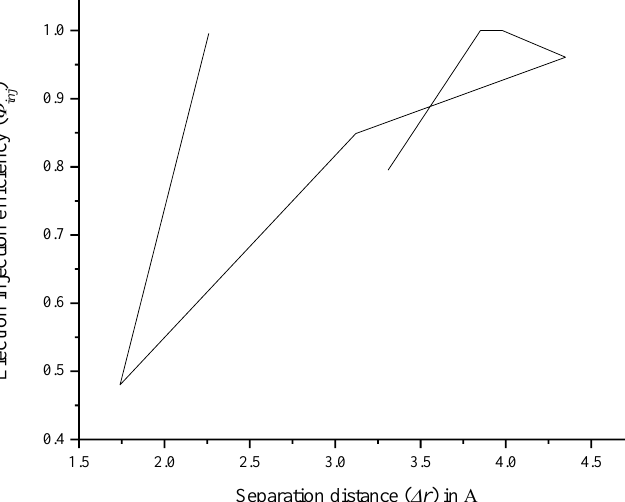
Figure 13. Graphical relationship between electron − hole separation distance and light-harvesting efficiency.